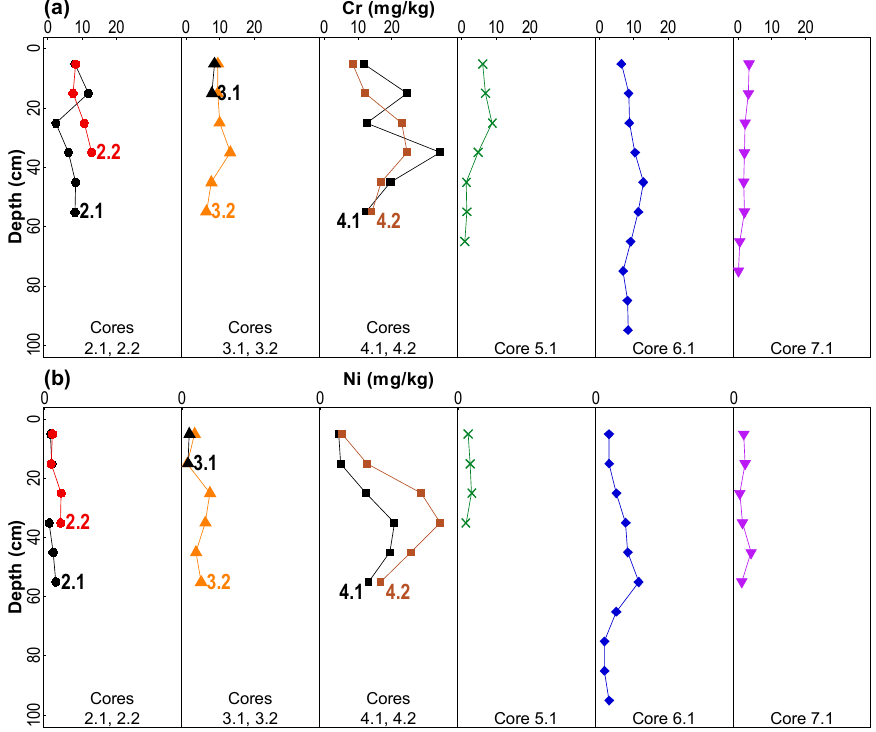
Figure 10. Depth profiles of ( a ) chromium (Cr) and ( b ) nickel (Ni) in soil cores collected from Smith’s Lake and Charles Veryard Reserves, City of Vincent, Western Australia. Core locations from Figure 1.